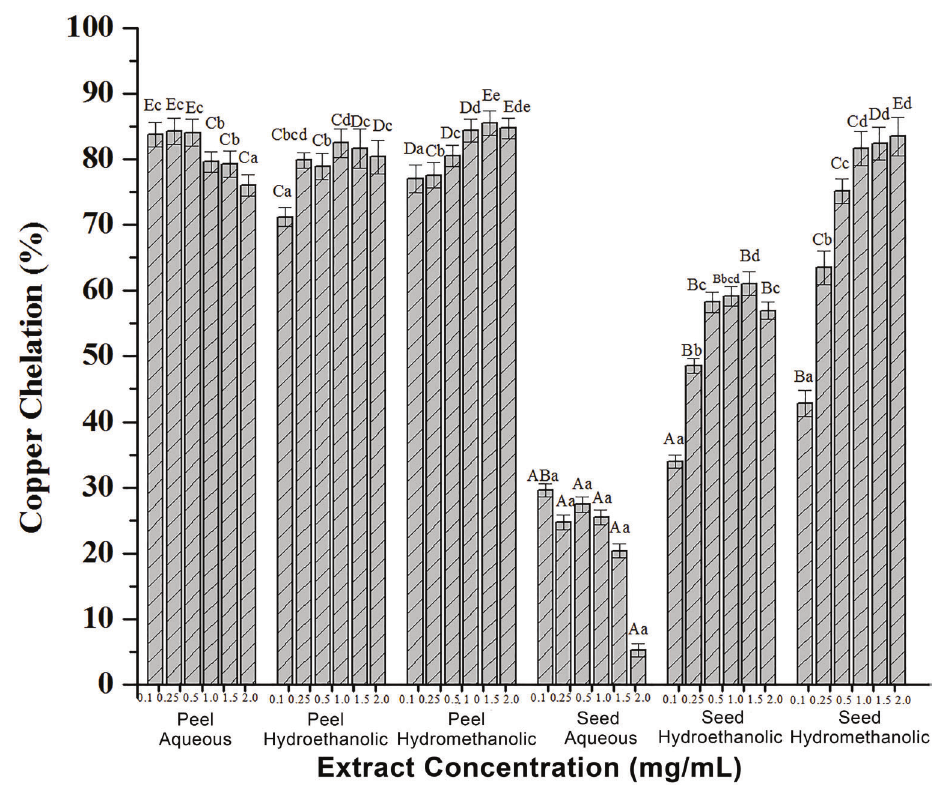
Figure 4. Antioxidant activity of melon peel and seed extracts by copper chelating effect. Different lower-case letters indicate a signi fi cant difference between melon residues extracts when compared at each concentration. Different upper-case letters indicate a signi fi cant difference between melon residues extracts at the same concentration (P o 0.05, ANOVA). Data are reported as means ± SD of 3